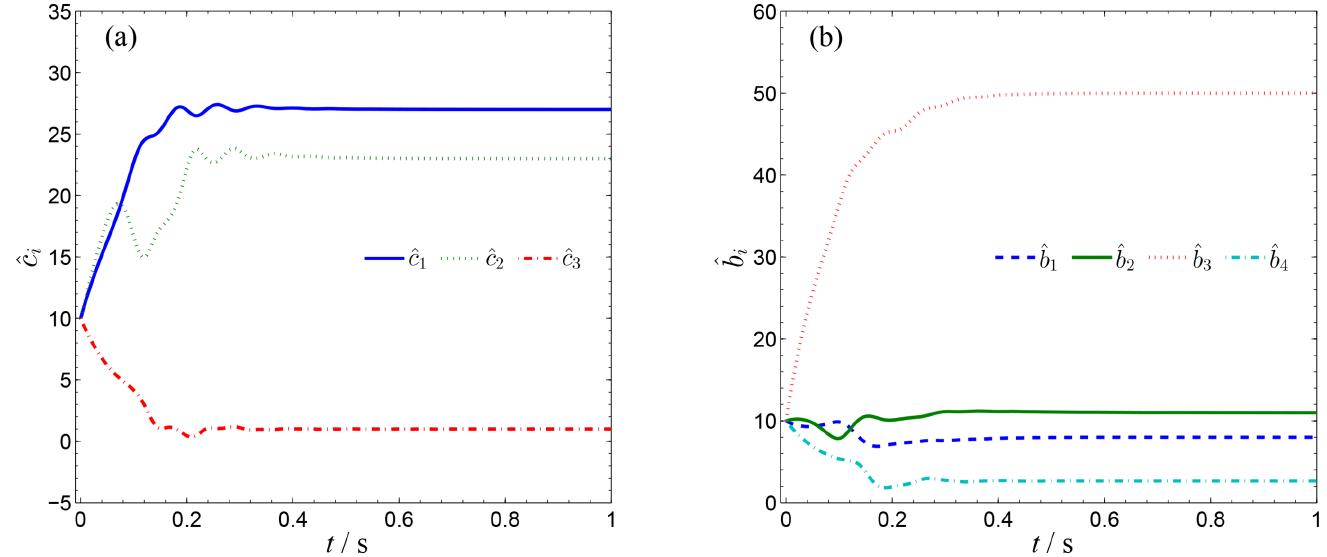
Fig 9. Identification of unknown parameters of systems (19) and (13). (a) ^ c 1 ; ^ c 2 ; ^ c 3 ; (b) ^ b 1 ; ^ b 2 ; ^ b 3 ; ^ b 4 .